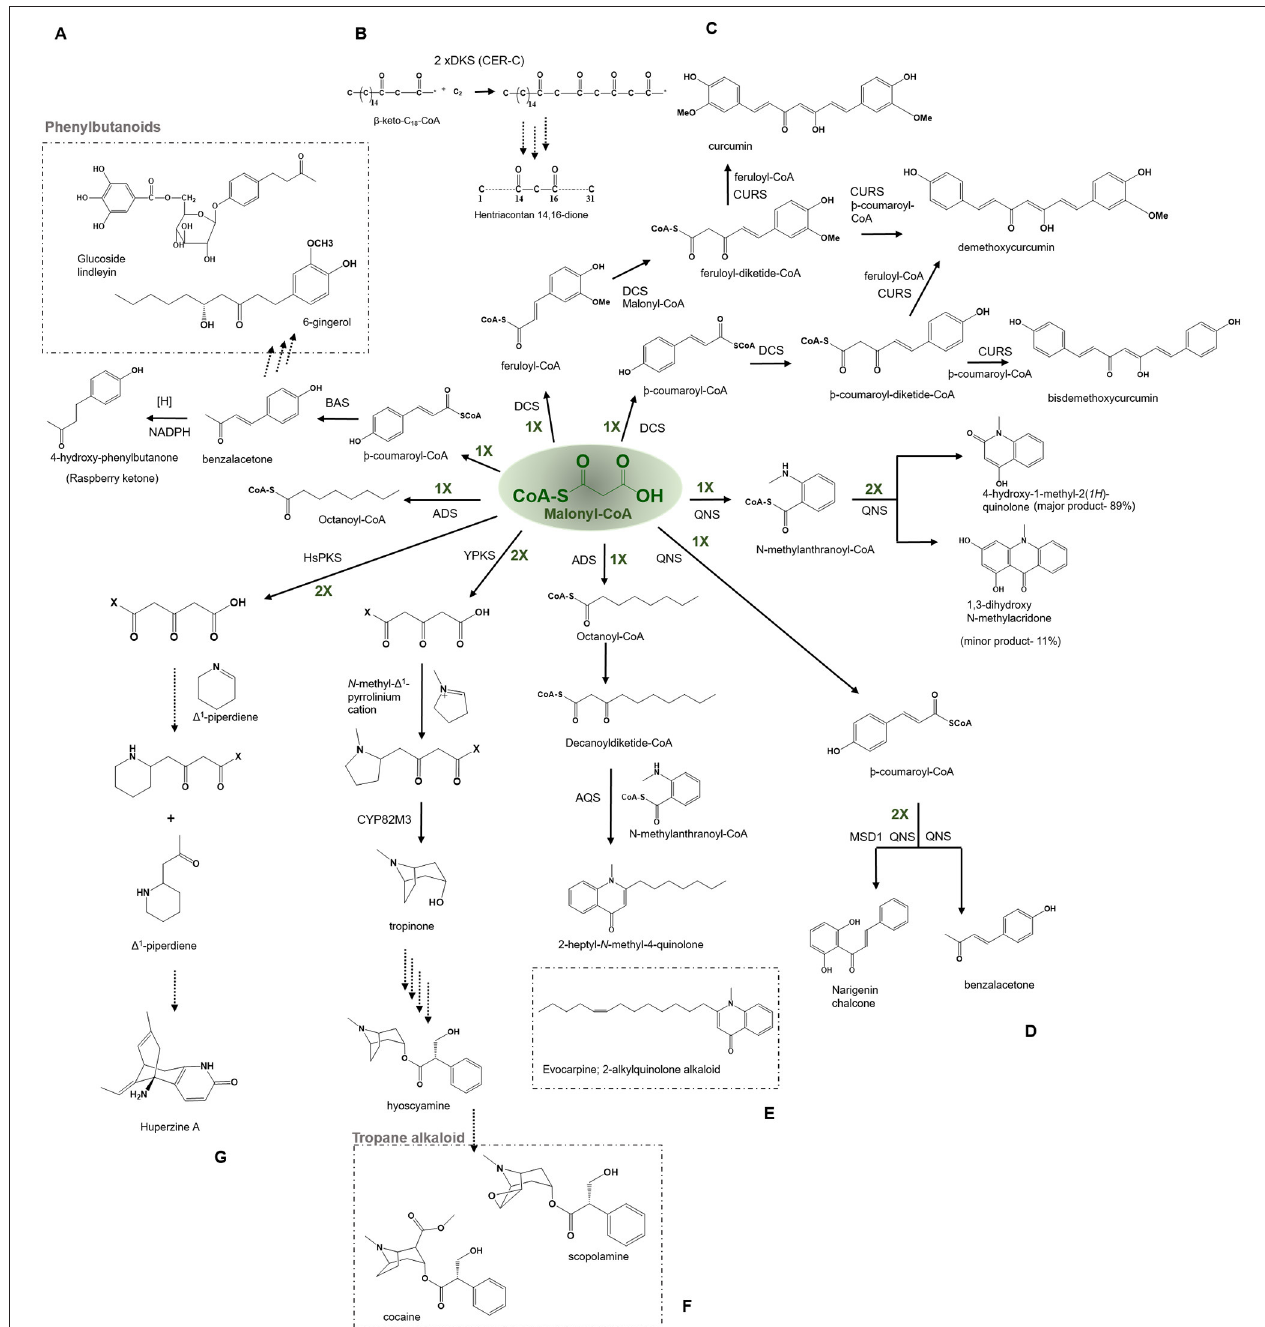
FIGURE 7 | Examples of non-cyclization based -type III PKSs to produce a variety of polyketide products. Describes the reaction catalyzed by (A) Benzalacetone synthases (BAS), (B) β -Diketone Synthase (DKS), (C) Diketide- CoA synthase (DCS) and Curcumin synthase (CURS1), (D) Quinolone synthase (QNS), (E) Alkyldiketide-CoA synthase (ADS) and alkylquinolone synthase (AQS), (F) polyketide like synthase (YPKS), and (G) Polyketide synthase (HsPKS); CYP82M3, cytochrome oxidase.